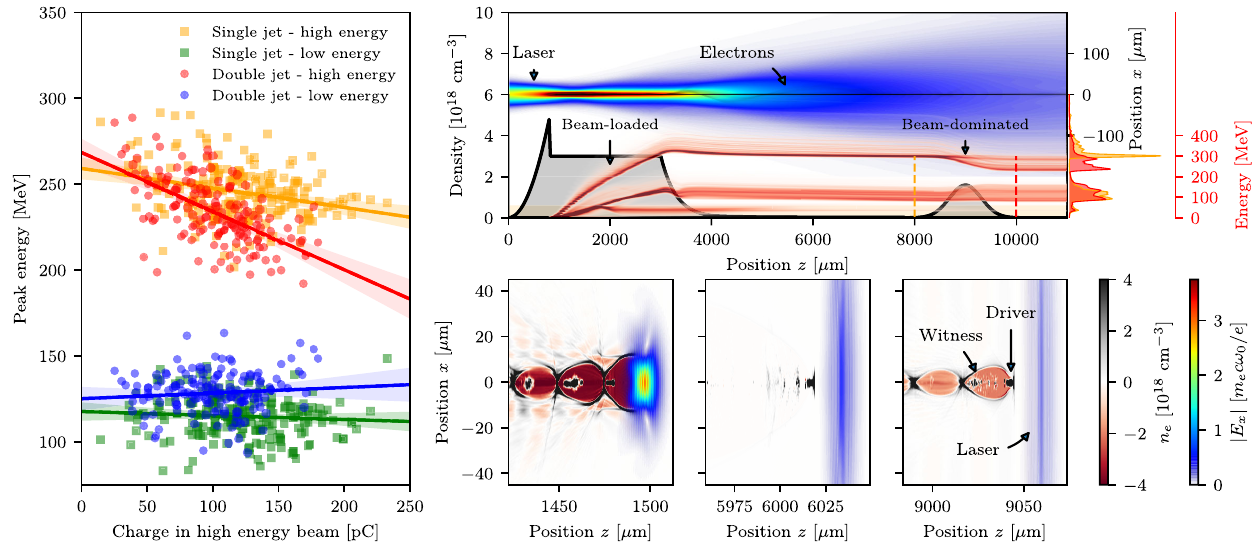
FIG. 5. Electron acceleration in the beam-dominated regime. Left: Energy from the driving electron bunch (high energy) is transferred to the witness bunch (low energy) in the second stage. The higher the drive bunch charge, the higher the witness energy gain. The driver itself, therefore, loses energy and charge. Top right: Results of a start-to-end simulation showing both the laser and beam evolution (upper part) as well as the plasma density (gray, lower part) and energy spectrum at each position (red). The leading electron beam contains a charge of 105 pC. It gets decelerated in the second jet, while a part of the second bunch is accelerated, just as observed in the experiment. The energy spectrum before the jet at z ¼ 8 mm and after the jet at z ¼ 10 mm is shown on the right. Bottom right: Snapshots for three different positions, i.e., inside the laser wakefield accelerator, during propagation in the near vacuum between both jets, and inside the beam-dominated second jet. The respective plasma densities and electric fields are color